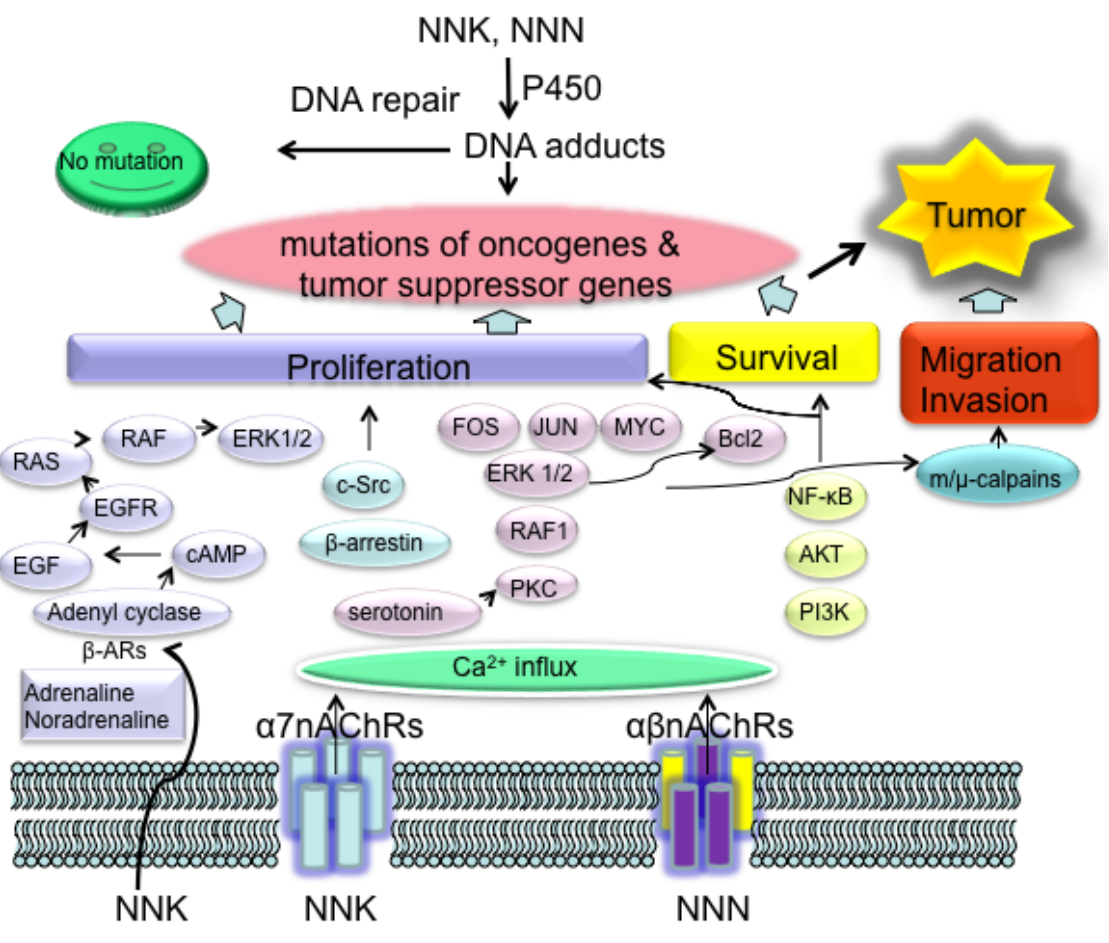
Figure 2. Two essential aspects of NNK- and NNN-induced cancer. Metabolic activated NNK and NNN induce DNA adducts, which can be eliminated by functional DNA repair networks. Unresolved DNA adducts further cause mutations in oncogenes and tumor suppressor genes, which consists of the first step of NNK and NNN specific carcinogenesis. Binding of NNK and NNN to nAChRs promote tumor growth by enhancing and deregulating cell proliferation, cell survival and cell migration as well as cell invasion, which is the second step of NNK- and NNN-induced cancer. The combination of these two aspects of the biological reactions of NNK and NNN provide the condition for tumor development